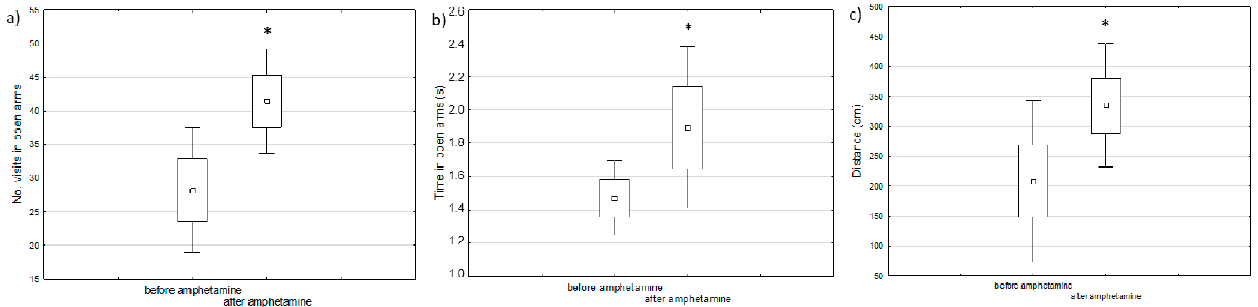
Figure 1. The comparison of behavioral changes before and after amphetamine injection in the elevated maze test: ( a ) number of visits in open arms, ( b ) time spent in open arms, ( c ) distance passed by the animals (paired t -test, * defines p < 0.05) .